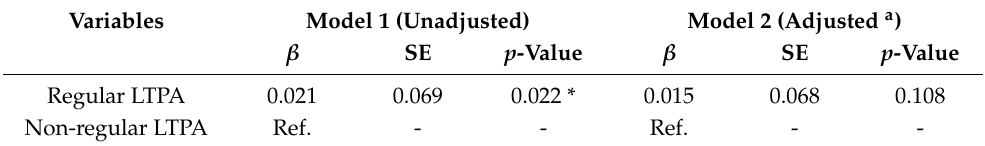
Table 4. Multivariate regression for regular LTPA and BMI